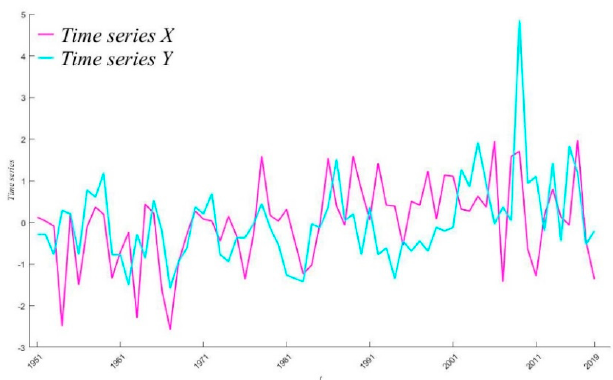
Figure 3. Time series X and Y (trend coefficients of X and Y are 0.36 and 0.34, respectively).